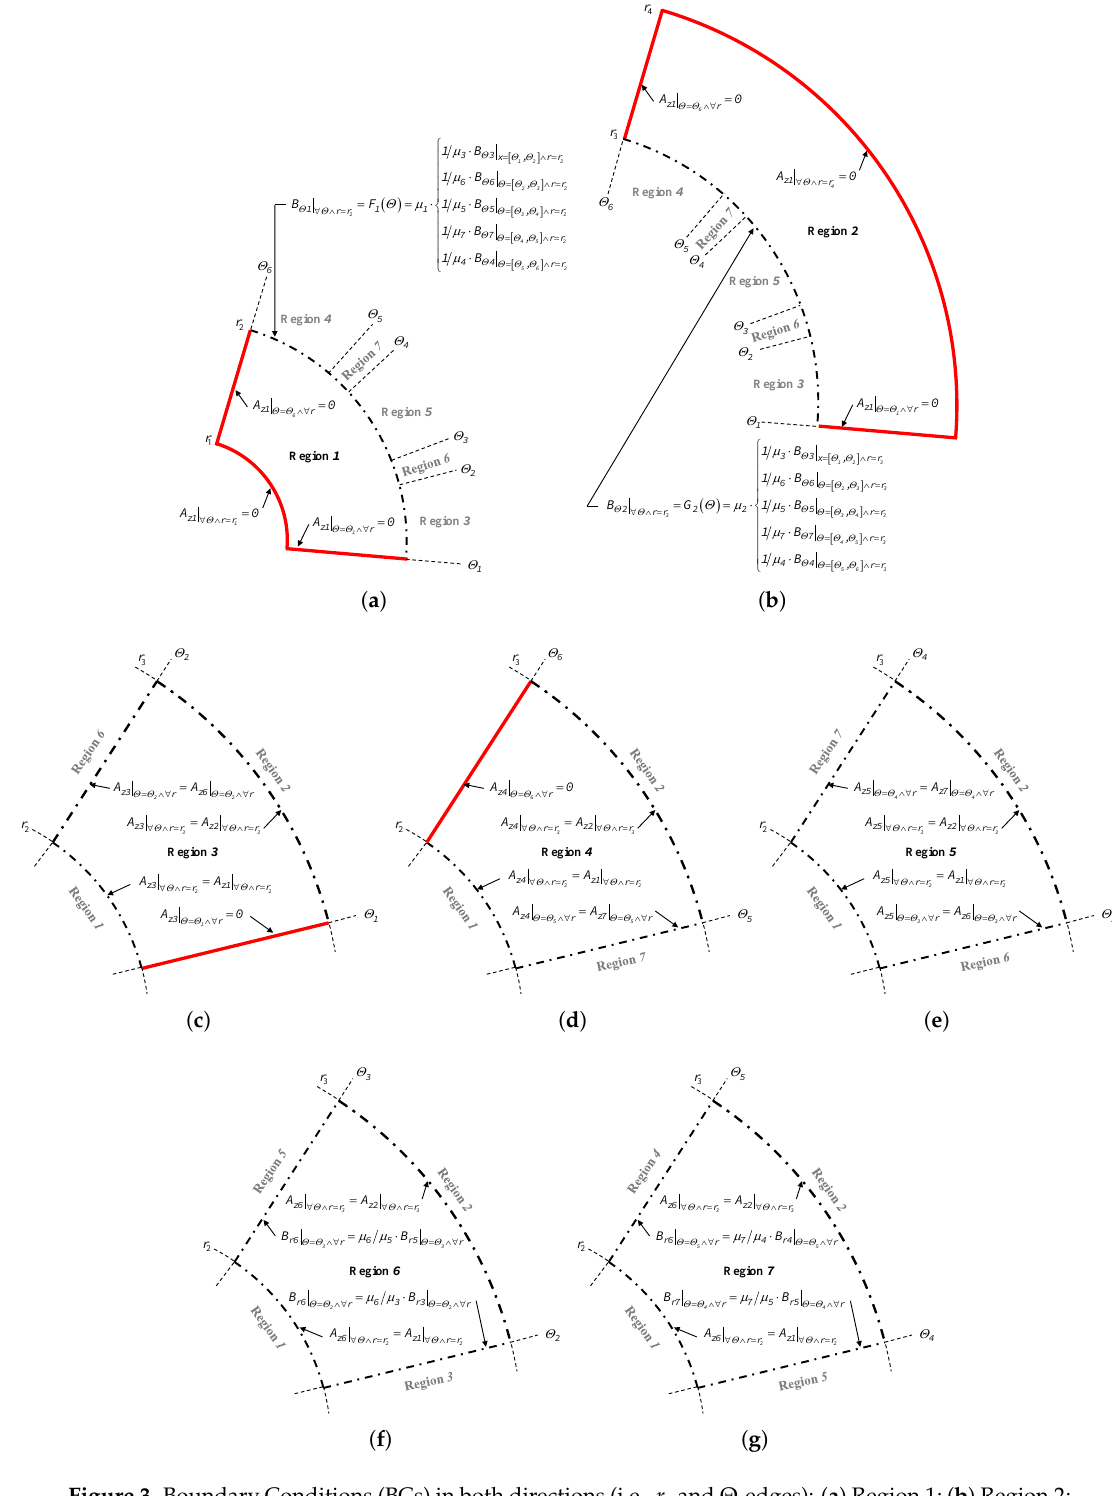
Figure 3. Boundary Conditions (BCs) in both directions (i.e., r - and Θ -edges): ( a ) Region 1; ( b ) Region 2; ( c ) Region 3; ( d ) Region 4; ( e ) Region 5; ( f ) Region 6; and ( g ) Region